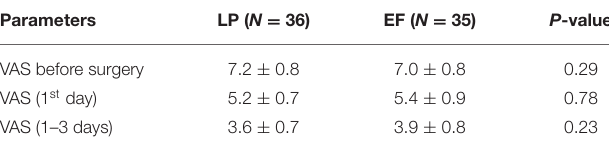
TABLE 3 | Pain management.